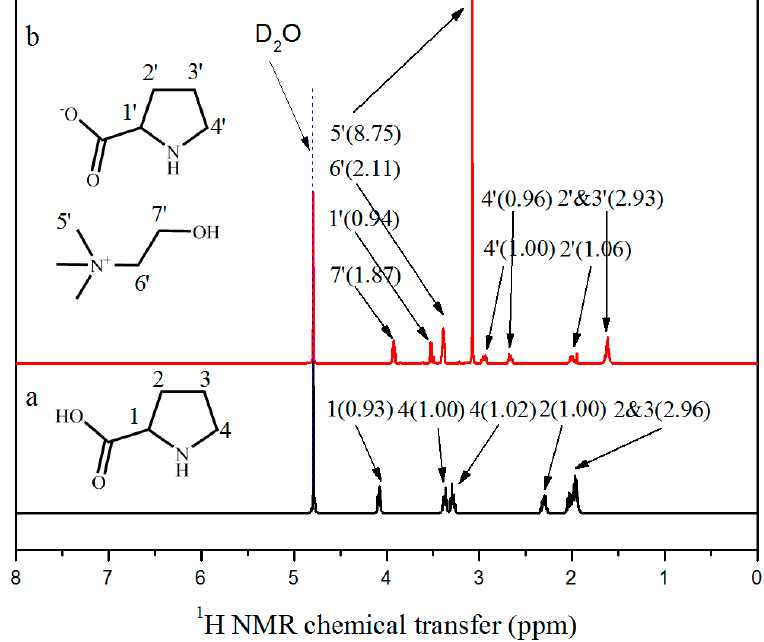
Figure 3. 1 H nuclear magnetic resonance spectra of ( a ) Pro and ( b ) ChPro. The solvent was D 2 O as indicated by peaks near 4.79 ppm.